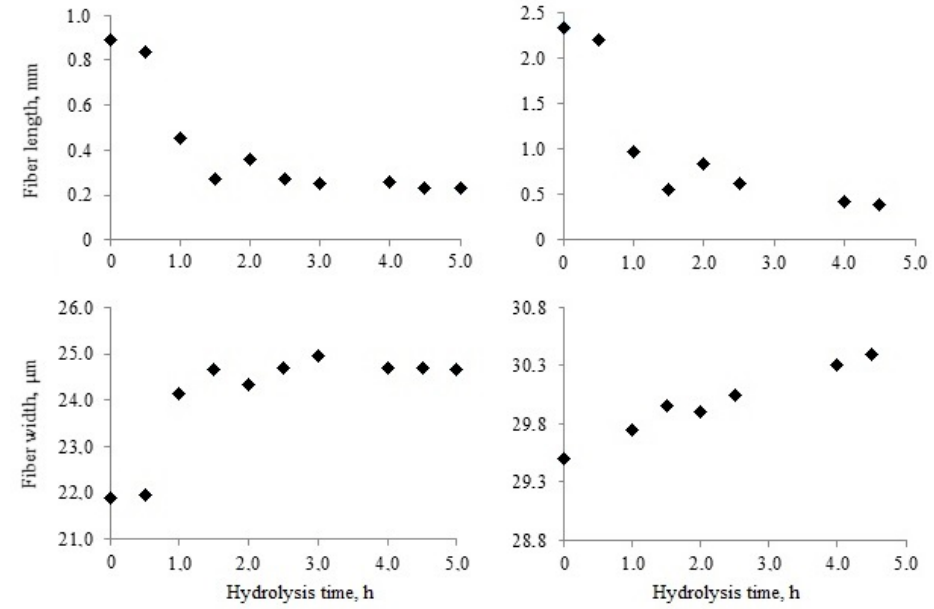
Figure 2. Fiber length and width of bleached hardwood pulp (BHP; left) and bleached softwood pulp (BSP; right) during enzymatic hydrolysis.